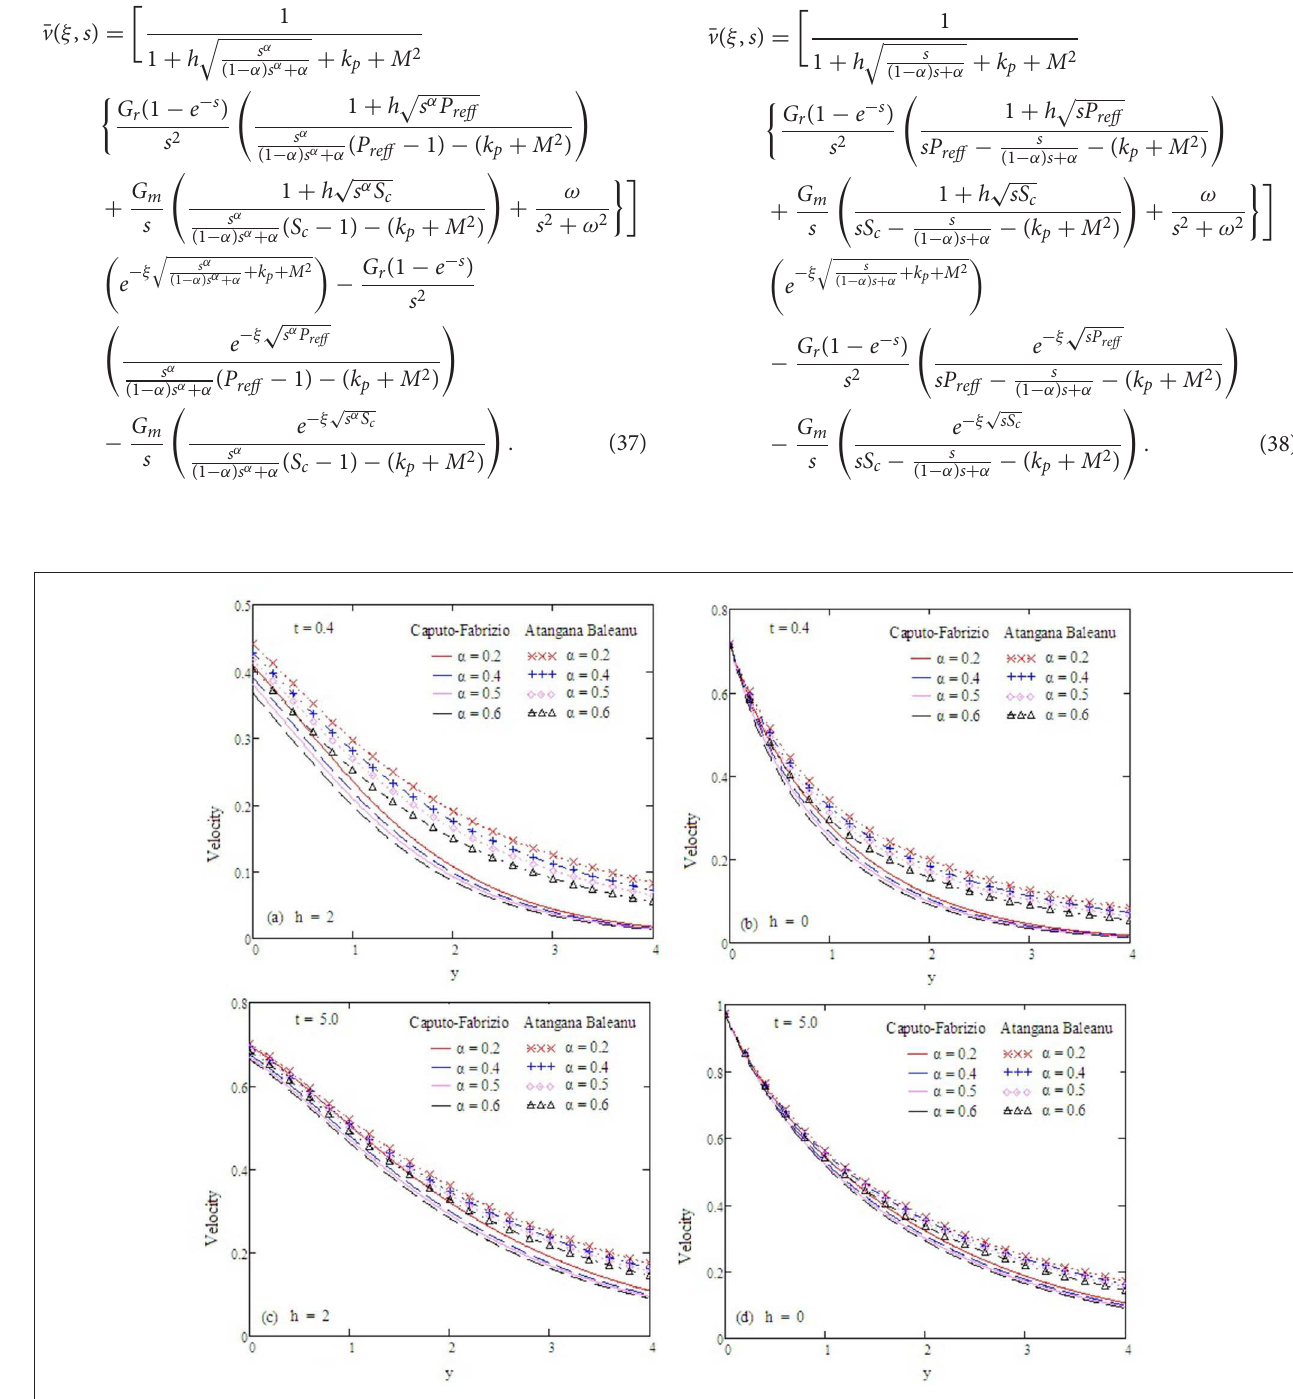
FIGURE 10 | Velocity profiles with altered values of α and other parameters are ω